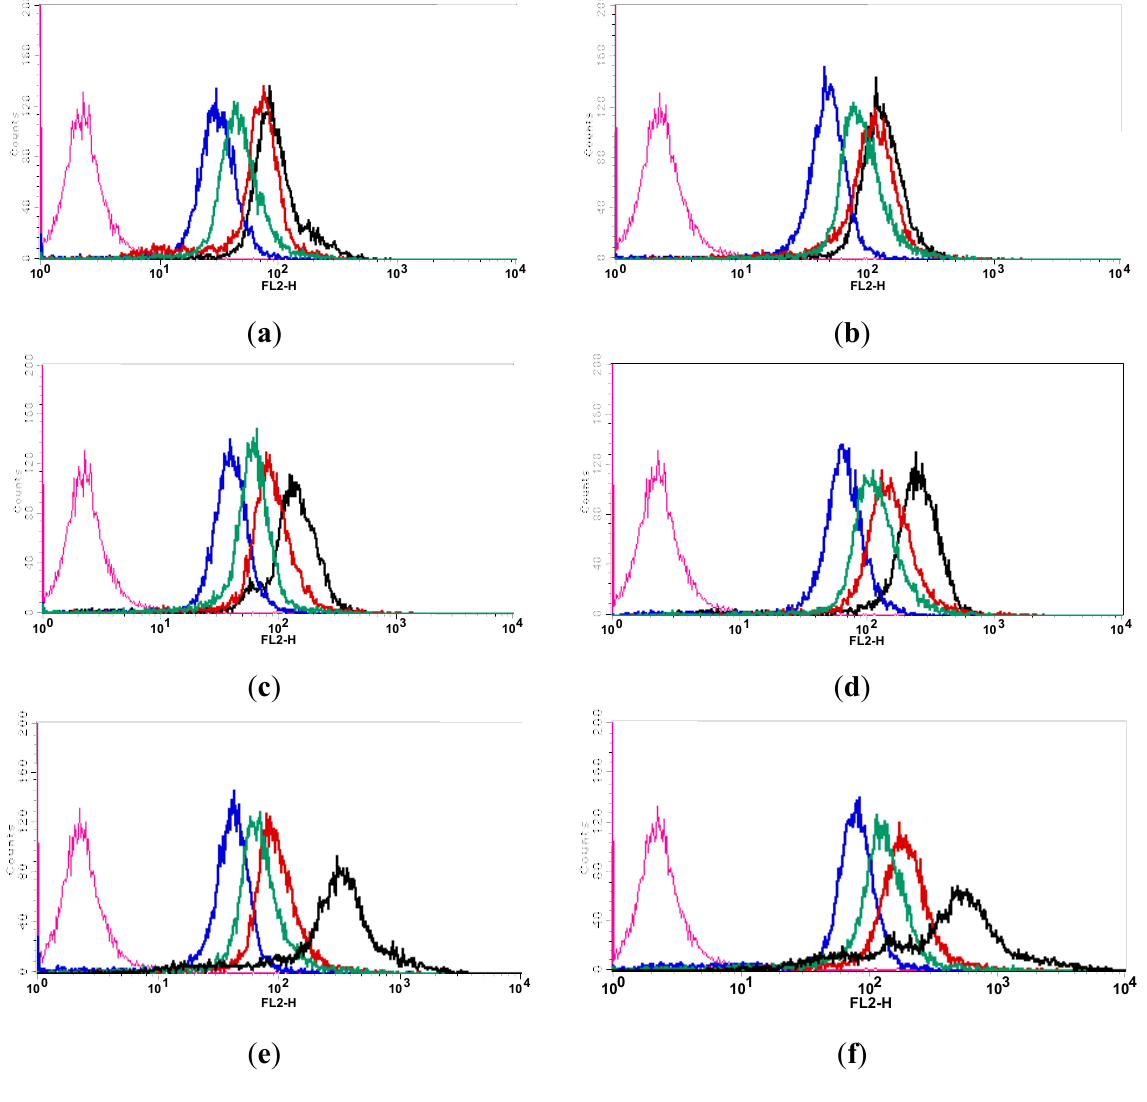
Figure 4. Flow cytometry histogram profile of KB cells that were incubated with free DOX, DOX-4SPCL-PEG-Folic micelle (DMC F) and DOX-4SPCL-PEG micelle (DMC 100 8 and 24 h with DOX concentration of 5µg/mL ( a , c , e ) and 10 µg/mL ( b , d , f ). (Pink: control, Blue line: DMC , Red: DMC F, Black: free DOX, Green: free folic acid + DMC 100 100 y -axis indicates the counts of the fluorescence